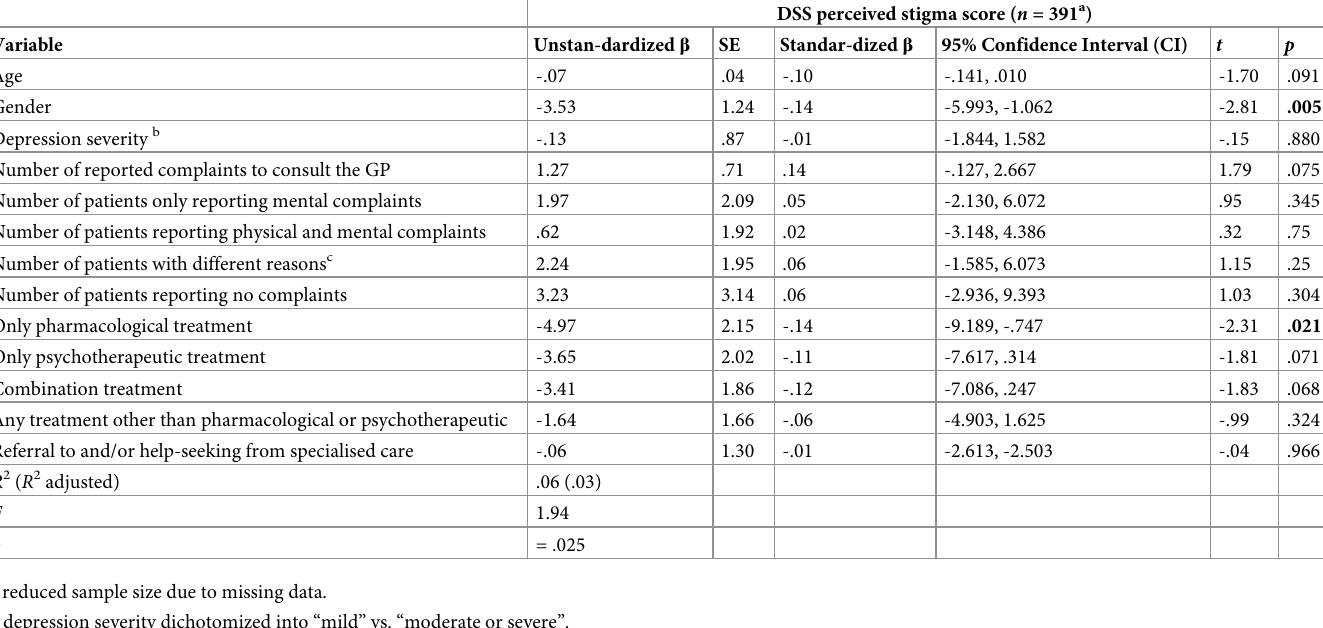
Table 2. Linear regression for predictors of perceived depression